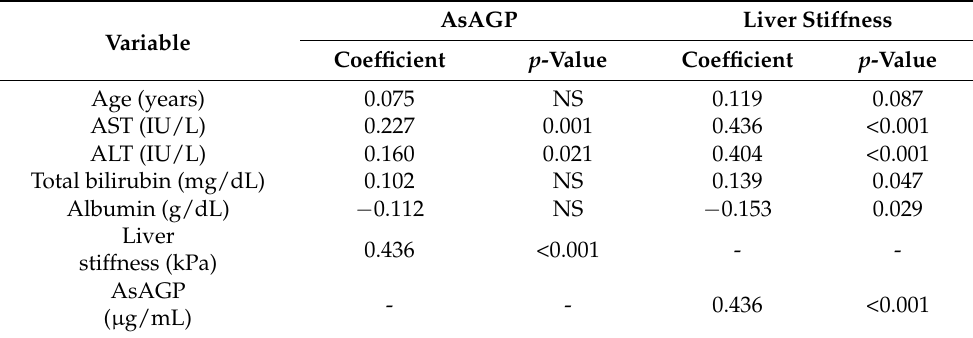
Table 4. Correlation between AsAGP levels, liver stiffness, and other